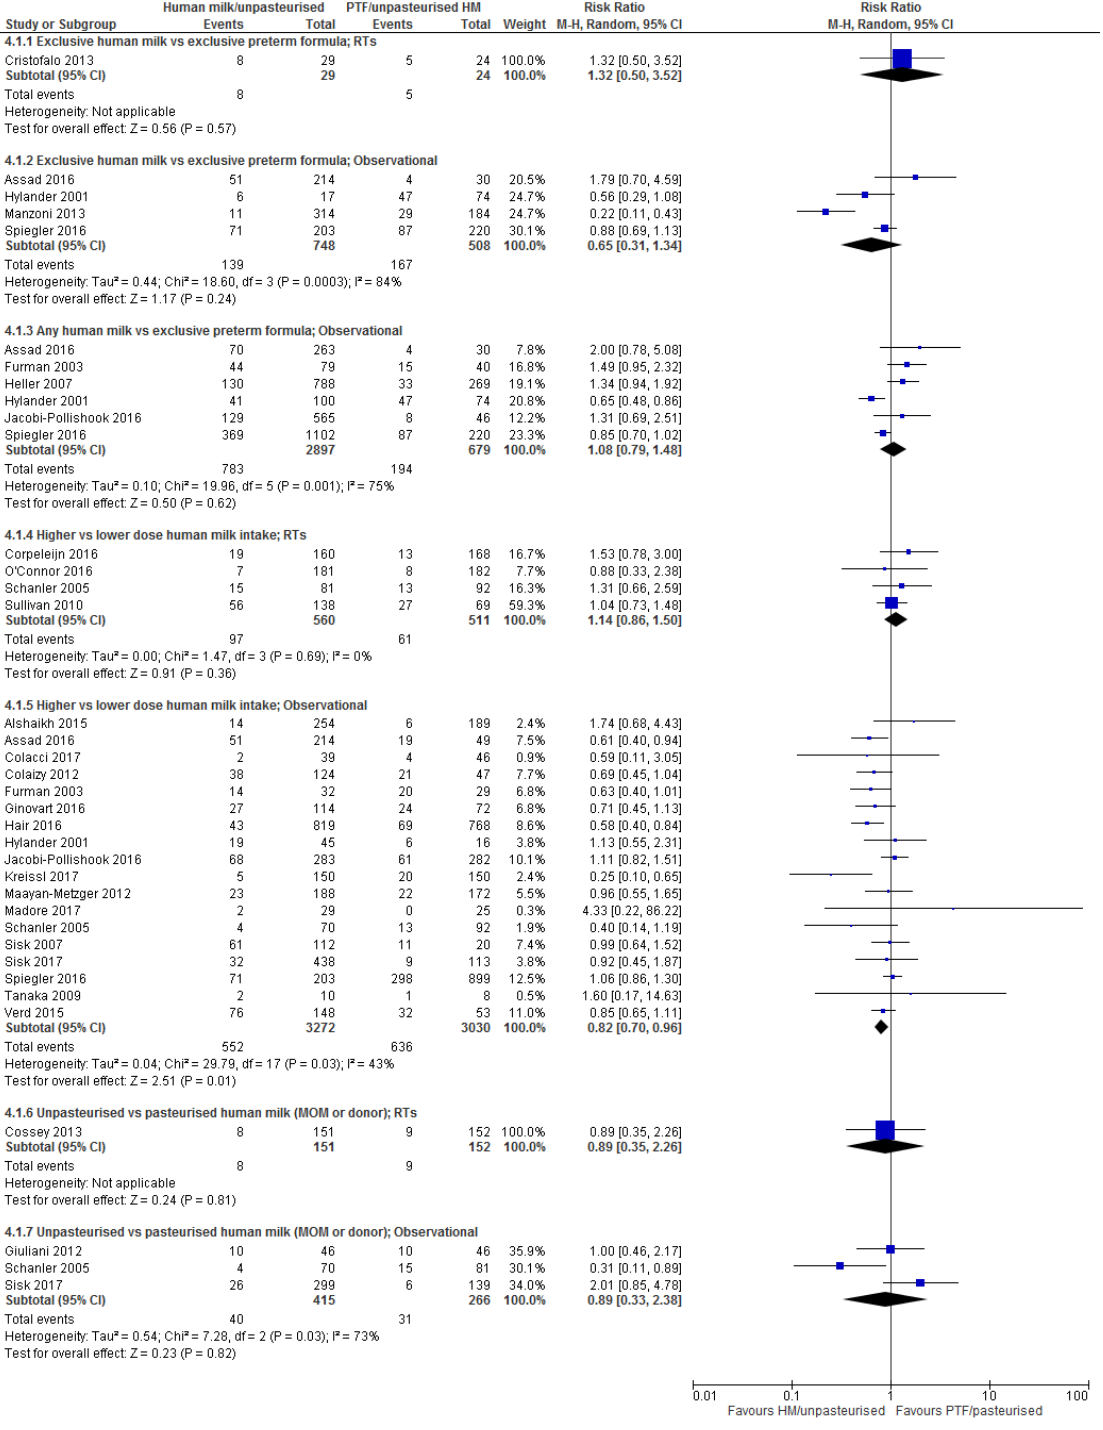
Figure 4. Forest plot of relative risk for the association between human milk and retinopathy of prematurity.